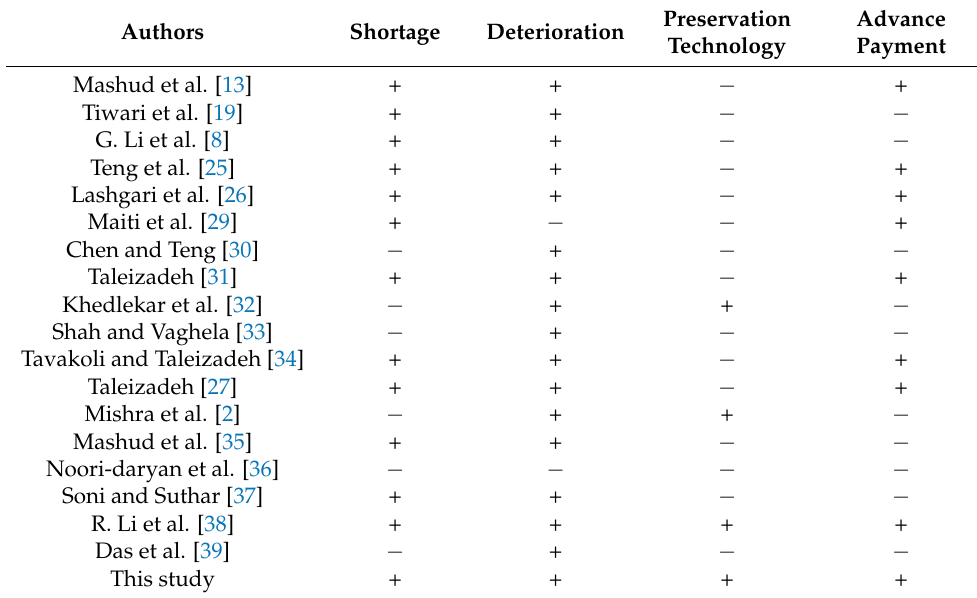
Table 1. Prior studies along with the related